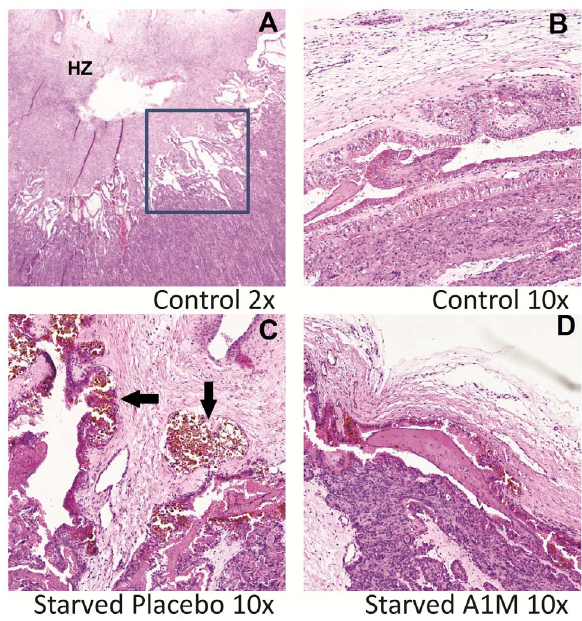
Figure 5. Placenta histology visualized by light microscopy. The histology of placenta was assessed in light microscopy of HE-stained slides. A. HE-stained placentome of a healthy control ewe at gestation d135 (2 6 magnification). The hilar zone is marked (HZ) and the square show the haemophagus area where differences were observed. B. HE stained haemophagus area of the placentome from a representative control ewe (10 6 magnification). C. HE stained haemophagus area of the placentome from a representative starved placebo ewe (10 6 magnification). Areas with increased erythrophagocytosis are marked with arrows. D. HE stained haemophagus area of the placentome from a representative starved A1M-treated ewe. Note the decreased amount of erythrocyte